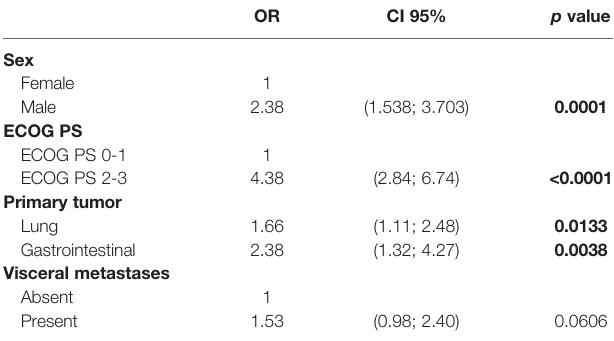
TABLE 2 | Univariate analysis investigating potential risk factors of 30-DM. TABLE 3 | Multivariate analysis investigating potential risk factors of